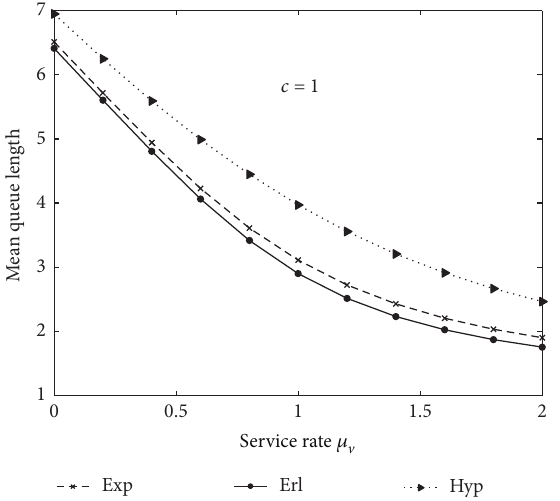
Figure 3: Mean queue length versus vacation-service rate with 𝜌 = 0.5 , 𝜉 = 0.1 , 𝜃 = 0.1 , and 𝑐 = 6 .